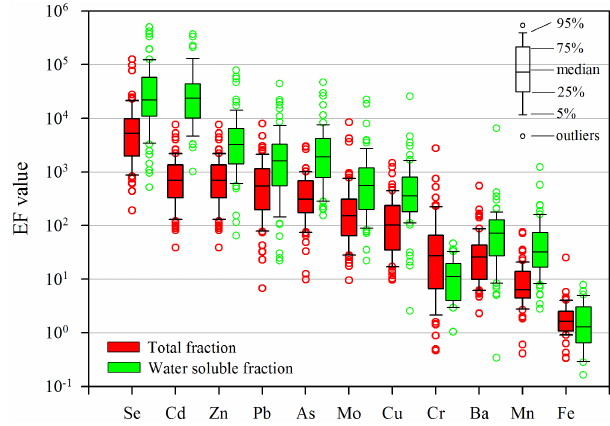
Figure 3. Enrichment factor (EF) values of fine particle trace ele- ments at Mt. Lushan in total and water-soluble